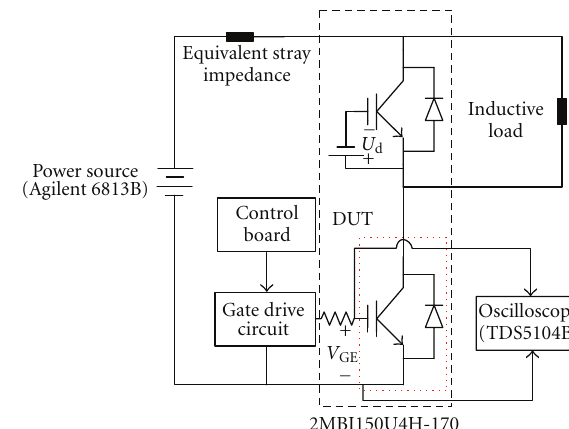
Figure 9: A test rig built for verification.